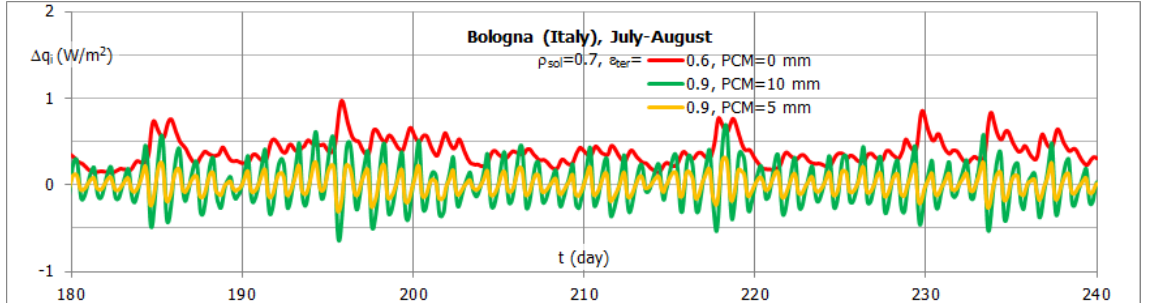
Figure 7. Change of the heat flowentering the inhabited space with respect to a typical cool roof with r sol =0.7, e ter =0.9.